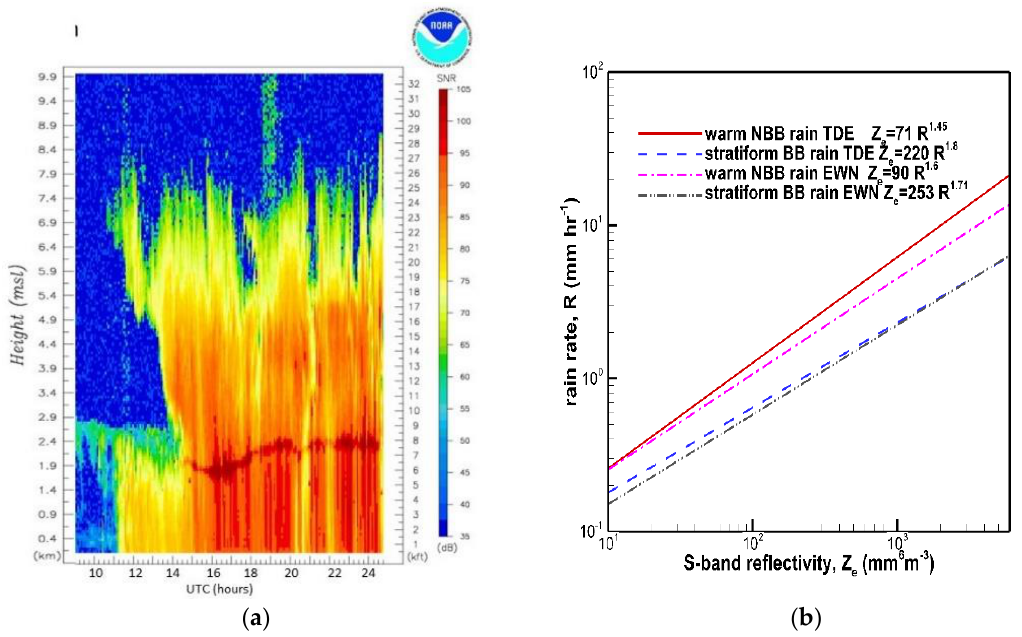
Figure 4. A precipitation event of 9 March 2017: ( a ) A time-height cross-section of signal-to-noise TDE S-Prof radar returns from the Physical Sciences Laboratory (PSL) Hydrometeorology Testbed (HMT) archive; ( b ) Corresponding Z e –R estimators.